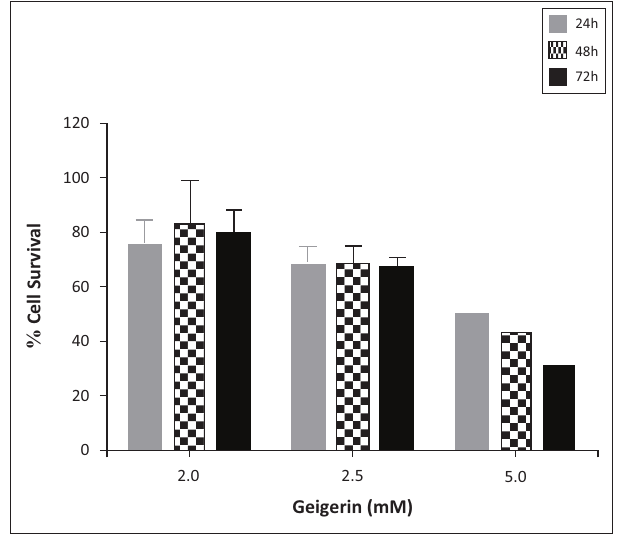
FIGURE 2: Assessment of cell survival using methyl-thiazol-tetrazolium assay following exposure of C2C12 myoblasts to geigerin (2.0 mM, 2.5 mM and 5.0 mM) for 24, 48 and 72